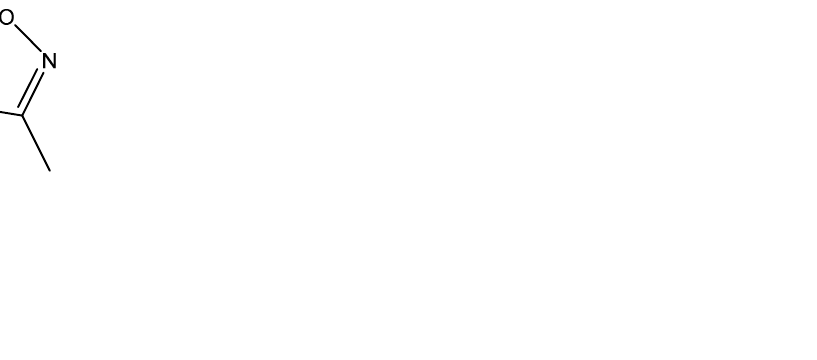
Figure 1. Chemical structure of 4-benzylidene-3 methyl-1,2-isoxazol-5(4H)-one (MBO).